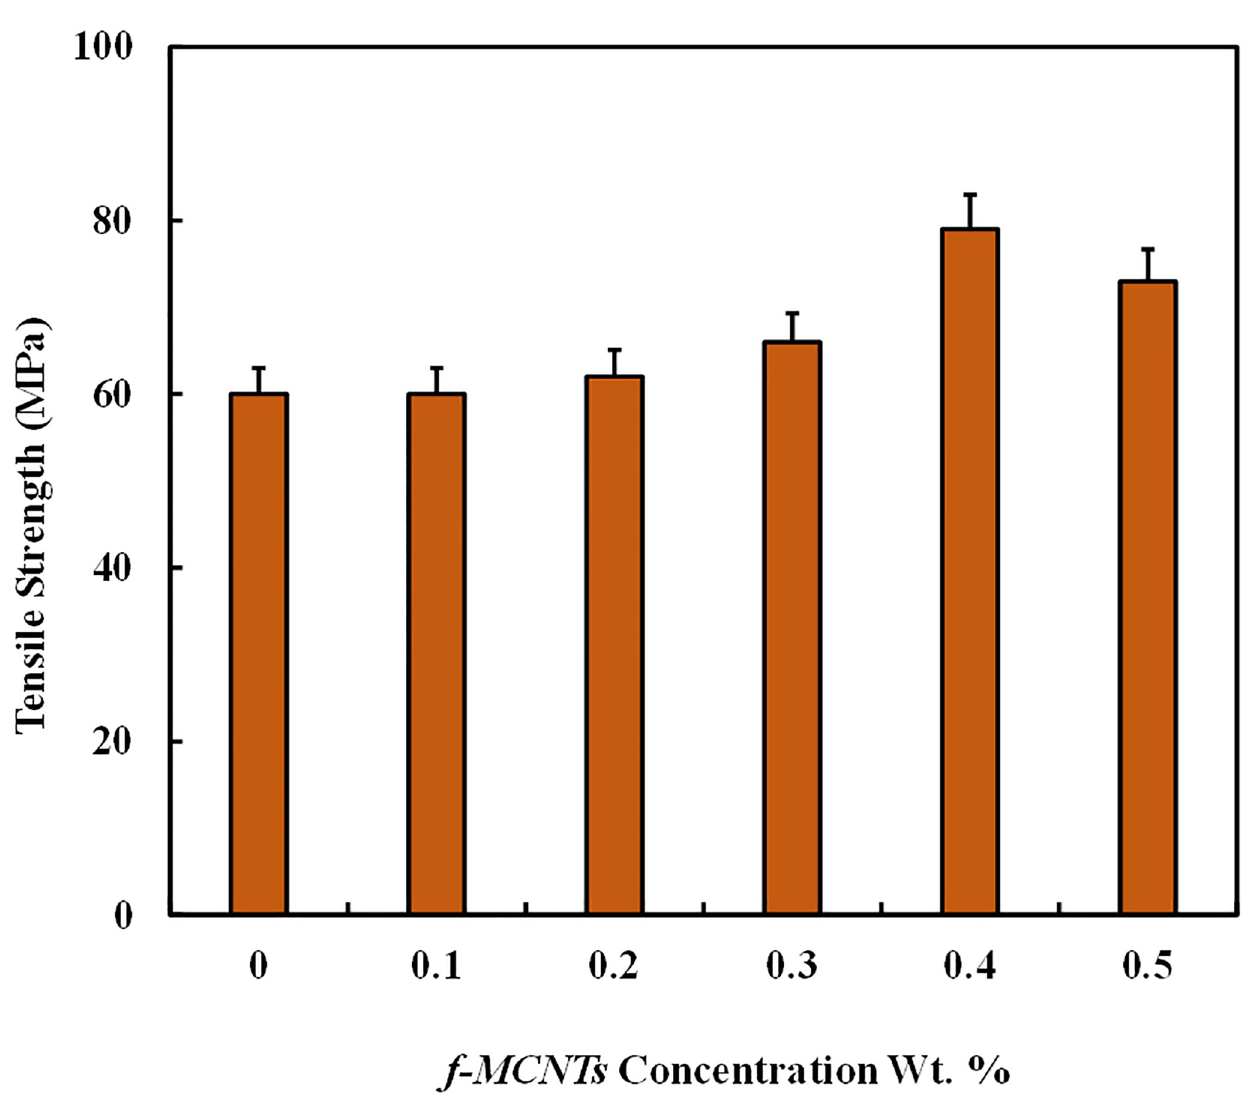
Fig 7. Effect of f -MWCNTs on tensile strength of